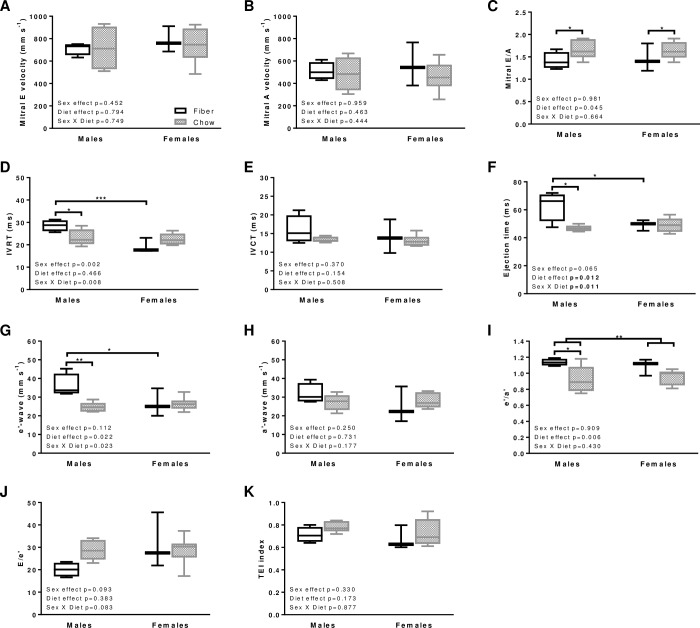
Diastolic function in males and females from the Fiber (black boxes) and Chow (grey boxes) groups.The figure includes mitral E velocity (A), mitral A velocity (B), E/A ratio (C), isovolumetric relaxation time (IVRT, D), isovolumetric contraction time (IVCT; E), ejection time (F), tissue Doppler e’-wave velocity (G), a’-wave velocity (H), ratio e’/a’ (I), ratio E/e’ (J), and myocardial performance index (TEI index, K). Boxes indicate the minimum, 25th percentile, median, 75th percentile, and maximum. In males, N equals 4 and 5 in the Fiber and Chow group, respectively. In females N equals 3 and 7–8 in the Fiber and Chow group, respectively. Significant differences between dietary groups or sexes are indicated with *** for p<0.001, ** for p<0.01 and* for p<0.05. Kruskal-Wallis results are indicated on each panel.